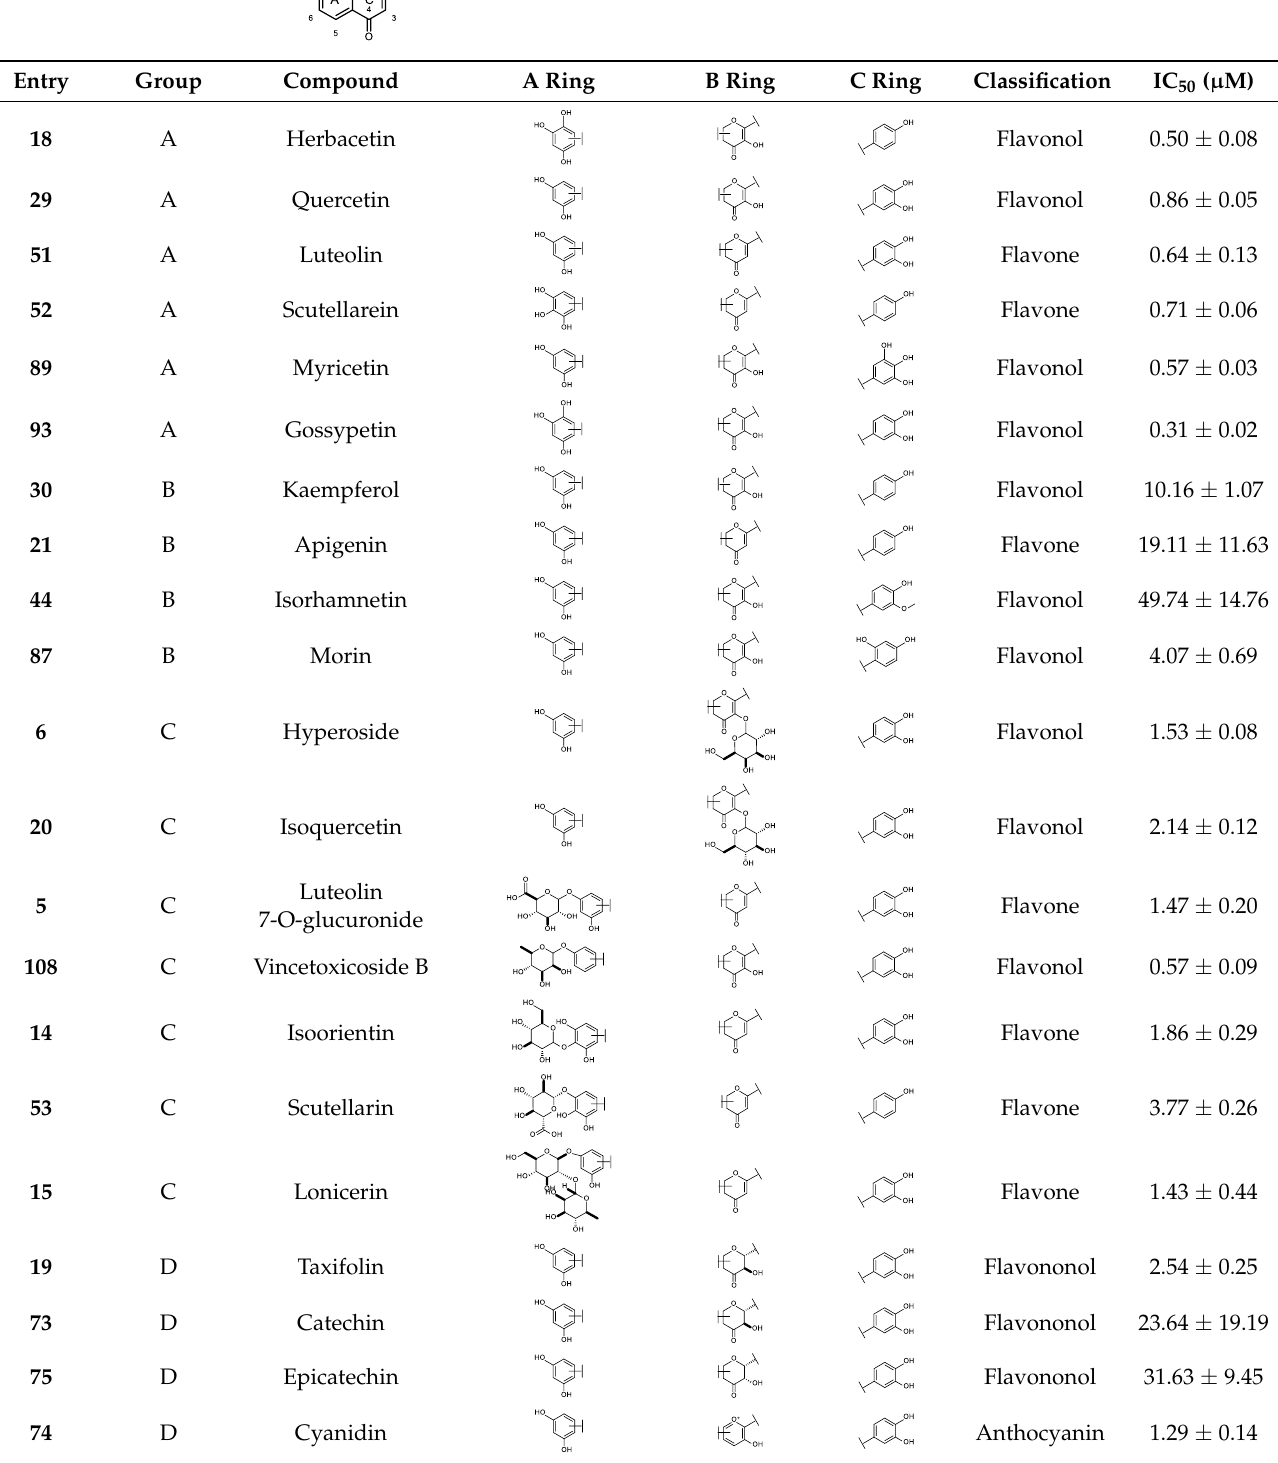
Figure 2. Concentration-response curves of flavonoids in four types: ( A ) ortho−dihydroxyphenyl flavonoids; ( B ) meta−dihydroxyphenyl flavonoids; ( C ) flavonoid glycosides; and ( D ) flavanonols and anthocyanins. Table 1. The SAR of the flavonoid inhibiting properties of ACLY.